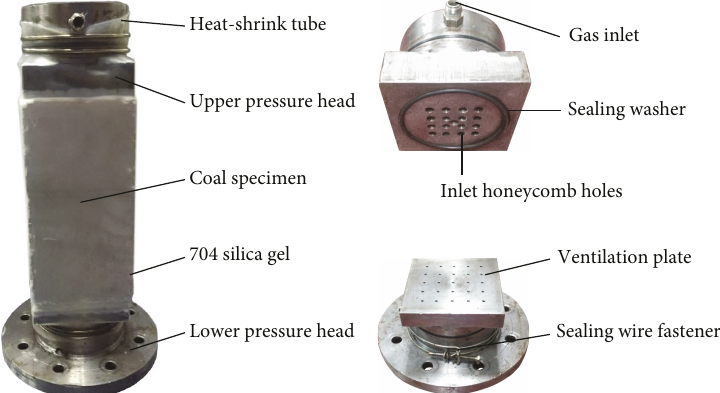
Figure 7: One well-sealed and installed test piece.